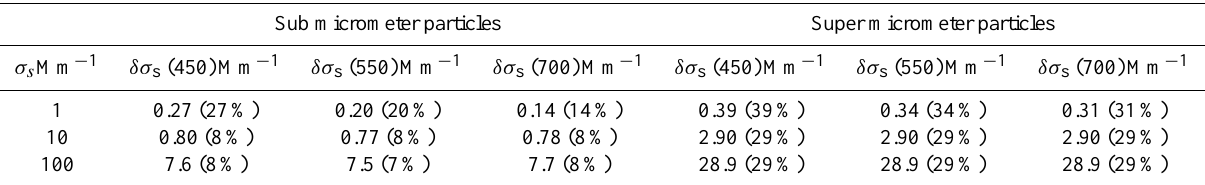
Fig. 1. The yellow circle marks the location of the TT34 measurement tower in the Sate of Amazonas, Brazil. The big red circles mark the position of some of the major cities in the Brazilian North and Northeast regions (more than 1.4 million inhabitants each). The small red circles mark the position of municipalities neighbor to the forest reserve (Rio Preto da Eva, Presidente Figueiredo, Novo Air˜ao), and municipalities eastern to the forest reserve in the State of Amazonas (Barreirinha, Itapiranga, Nhamund´a, Parintins, S˜ao Sebasti˜ao do Uatum˜a, Silves and Urucar´a). Table 1. Uncertainties ( δσ s ) estimated for 30min averaging periods for scattering coefficients ( σ s ) ranging between 1 and 100Mm − 1 , for sub micrometer and super micrometer aerosol particles. Relative errors are shown in